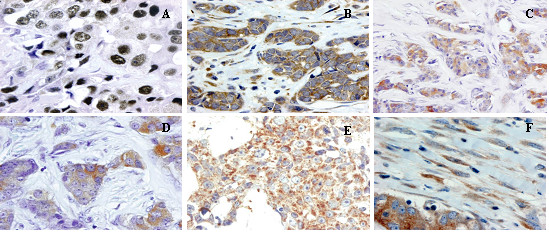
Microphotographs representative of malignant cells positive for AR (A), MMP-1 (B), MMP-7 (C), MMP-13 (D) and TIMP-2 (E) and fibroblasts positive for MMP-1 (F). Magnification 400×.